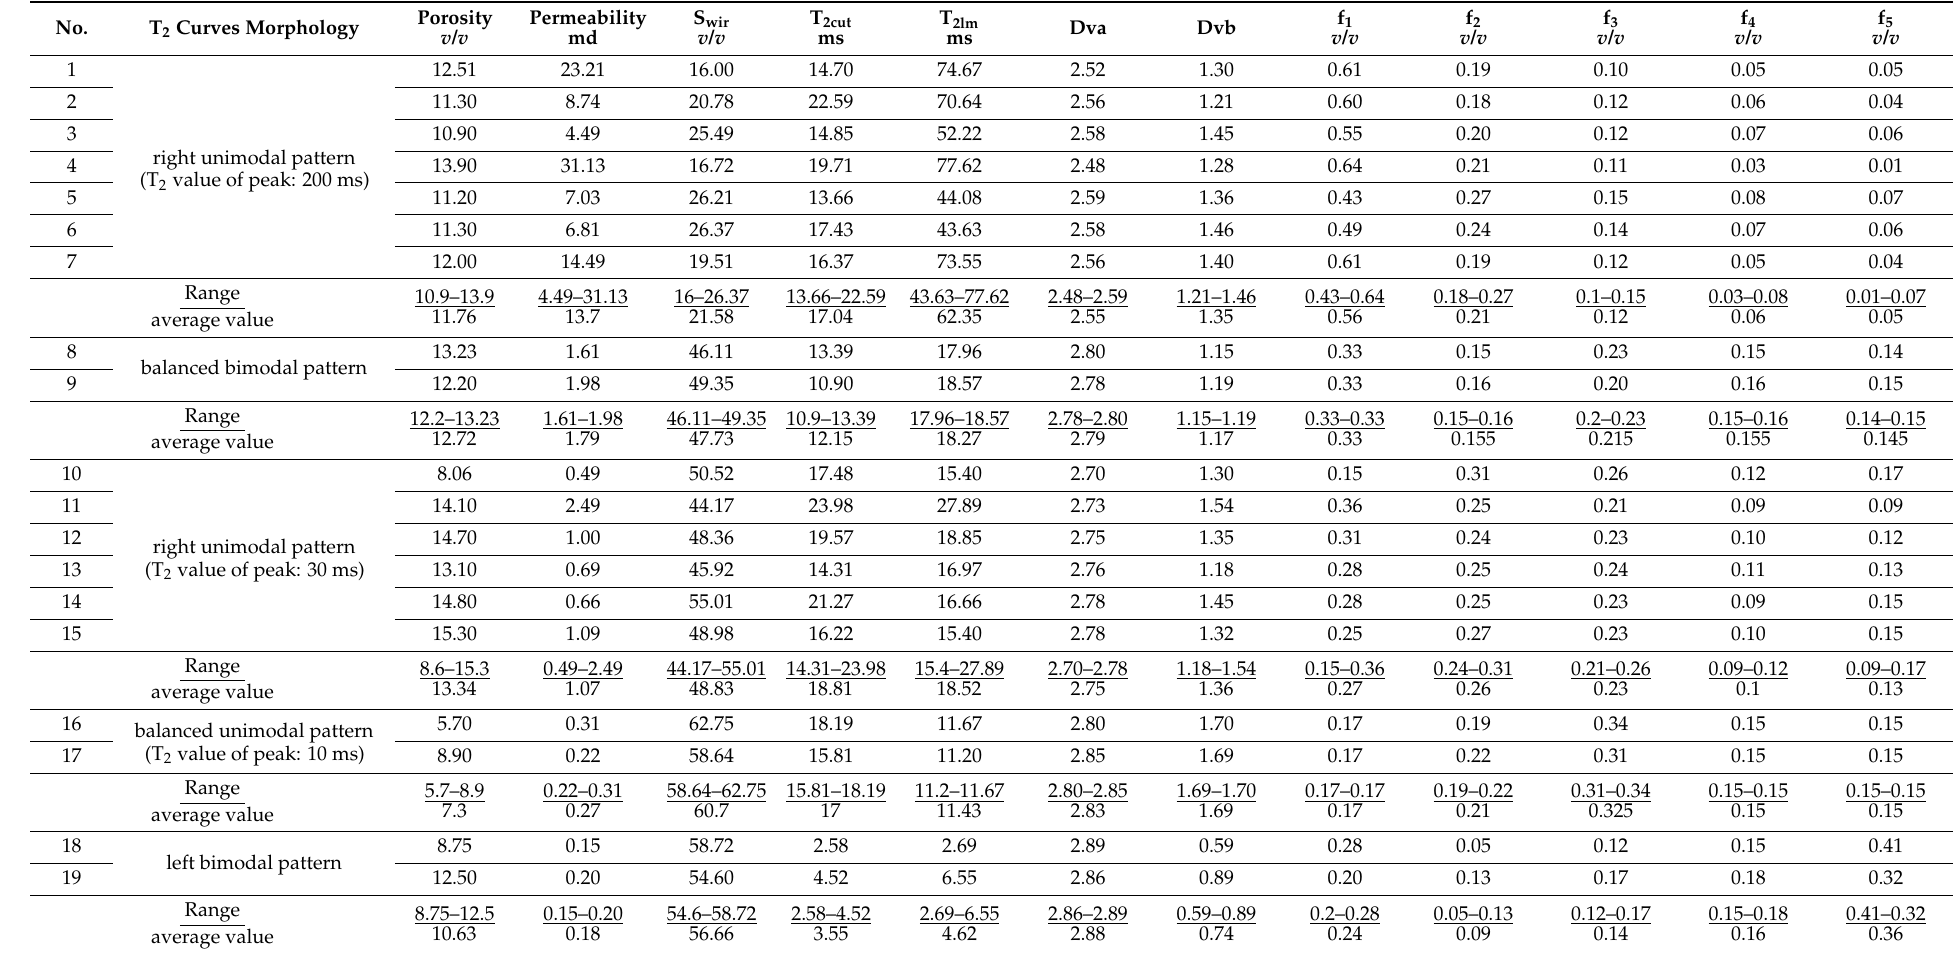
Table 1. Specific parameters of 19 rock